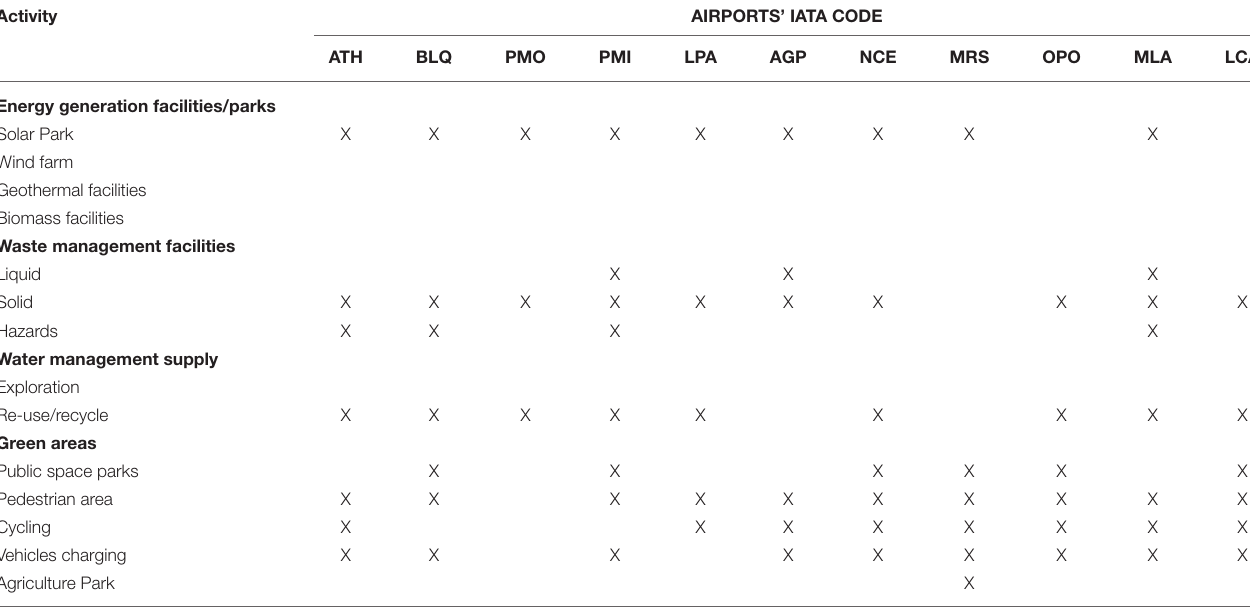
TABLE 3 | Key Elements of airports’ renewable green facilities for popular tourist destinations in Mediterranean.